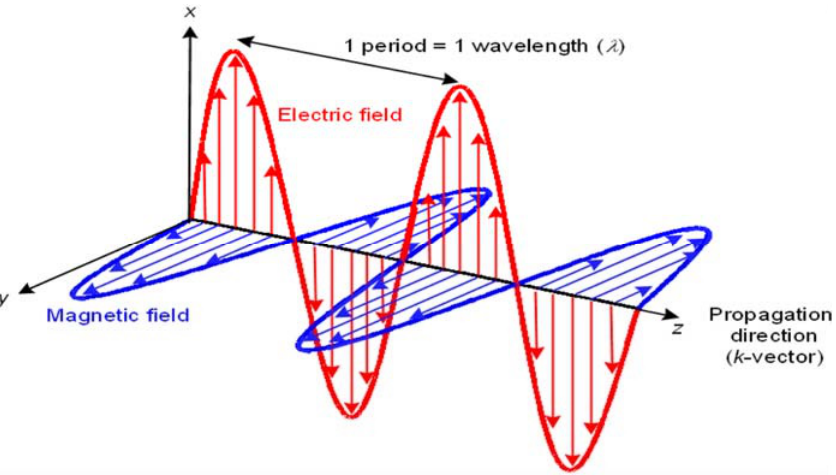
Figure 3. Electromagnetic wave diagram. Showing the direction of the wave, the direction and oscillation of the electric field and the direction and oscillation of the magnetic field. Each runs perpendicular to another; direction travelling along the X ‐ axis, electric along the Y ‐ axis and mag ‐ netic along the Z ‐ axis